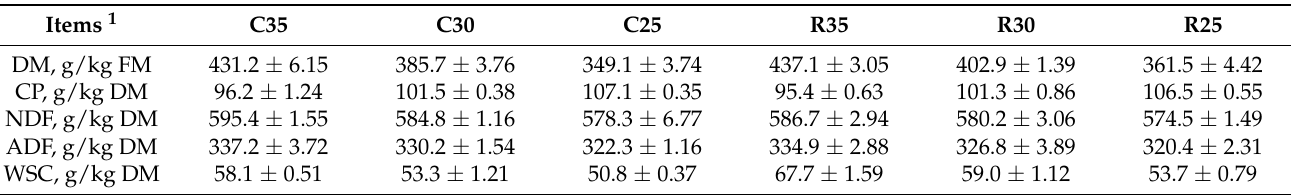
Table 2. Chemical composition of each group before mixed silage (Mean ± SD, n = 3).